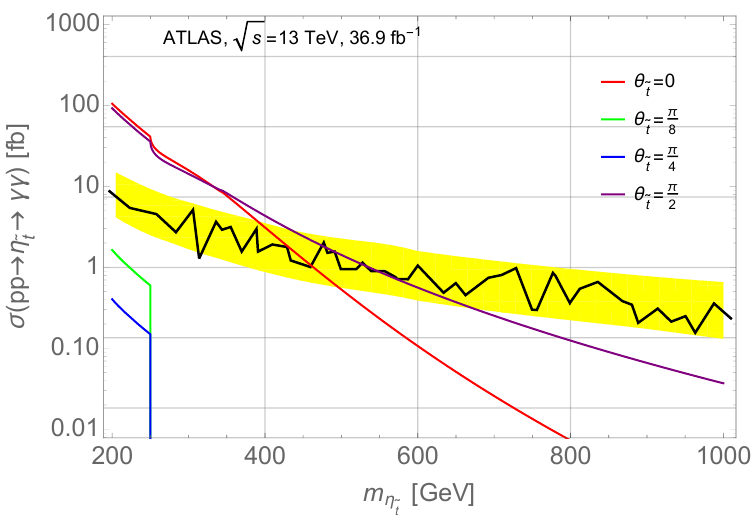
Figure 2 . Constraint on the stoponium from the LHC-13 TeV diphoton resonance data. The 2 (cid:27) experimental upper limit (yellow band) is taken from [45]. Here we also assumed tan (cid:12) = 10 and m ~ = 2 t 2